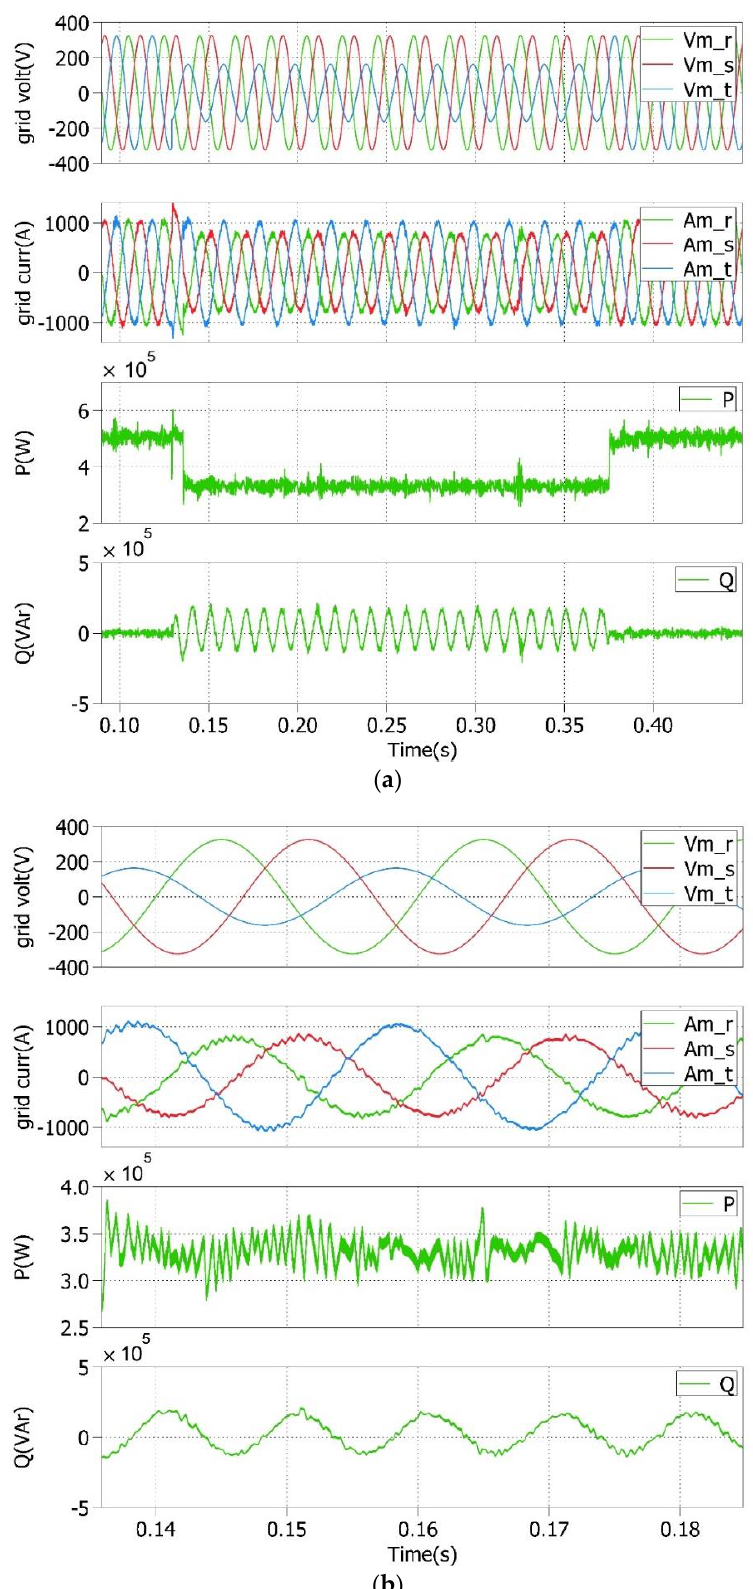
Figure 7. ( a ) Grid voltages, currents, and P and Q during an asymmetrical moderate voltage sag of 50% in phase 3; ( b ) detailed view during the faulty operating conditions.